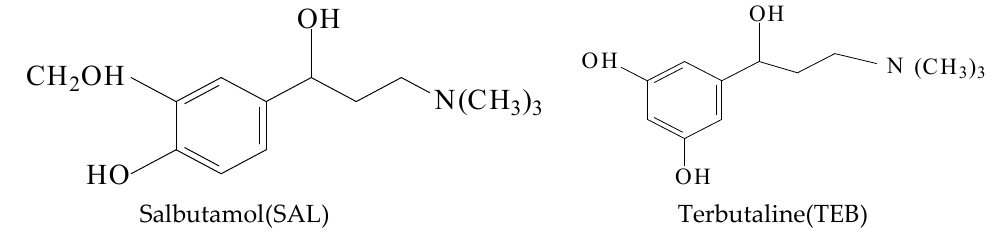
Figure 1. Salbutamol and terbutaline chemical structures.